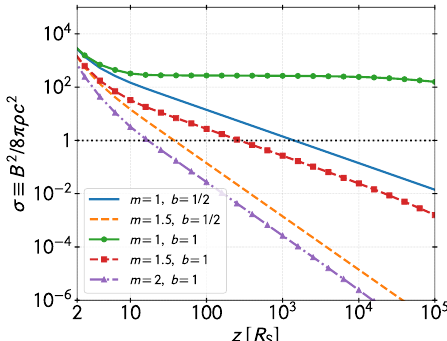
Figure 12. Magnetization along the jet for different topologies of the magnetic field and different jet shapes. The cases where b = 1 correspond to a conical jet and b = 1/2 to a parabolic jet. The magnetic field intensity decays as ∼ z − m , where m = 1 represents a purely toroidal magnetic field and m = 2 a purely poloidal